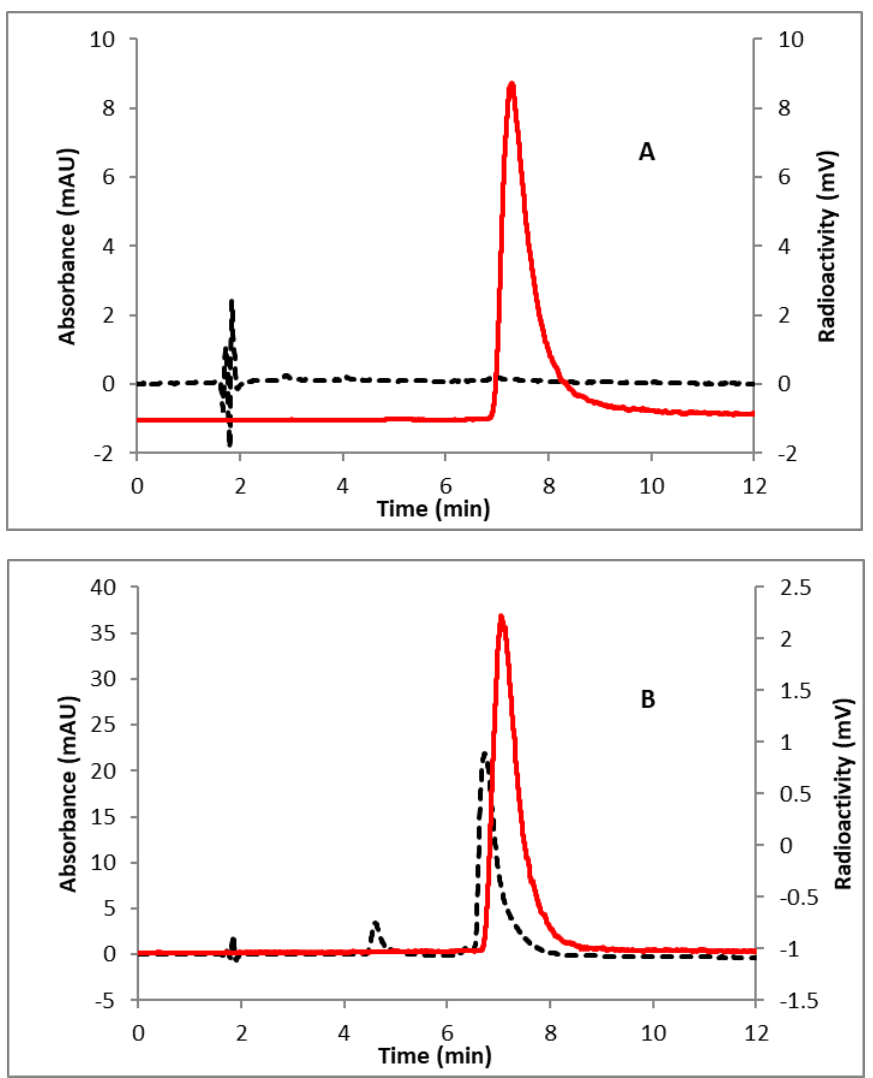
Figure 3. Schematic diagram of the automated synthesis of 6-[ 18 F]FPy-CONH-T140 on GE FX-N Pro Module.